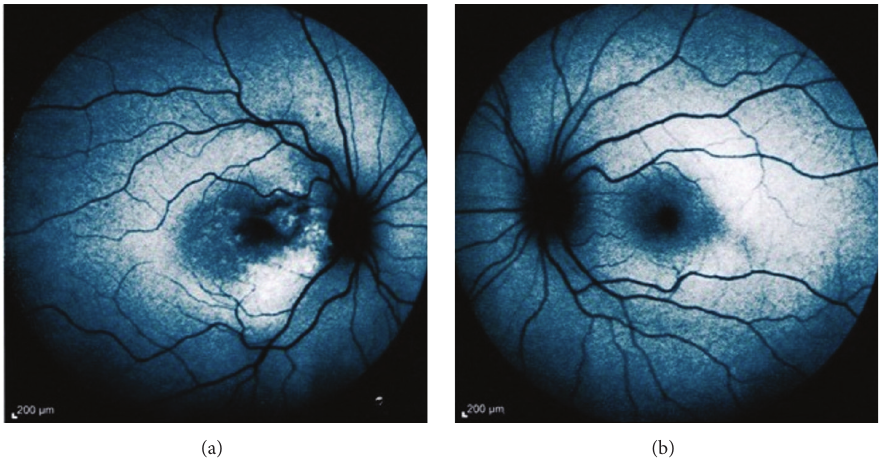
Figure 2: Fundus autofluorescence image shows variable hypo- and hyperautofluorescence in the right eye. In the left eye, isoautofluorescence of macula is evident.